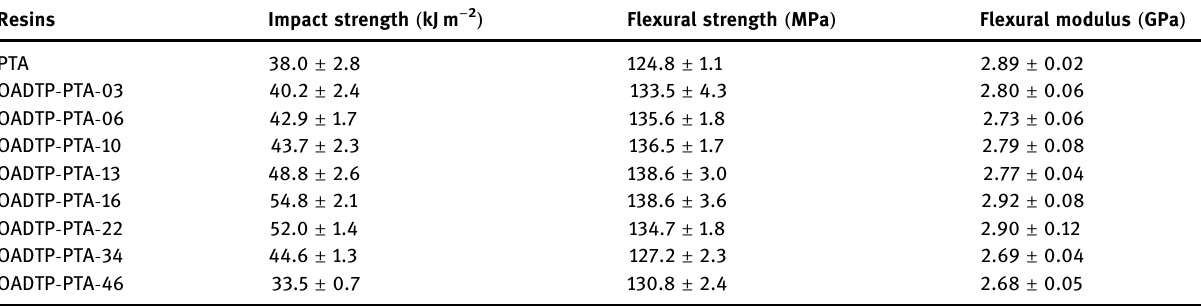
Table 3: Mechanical properties of cured OADTP - PTA